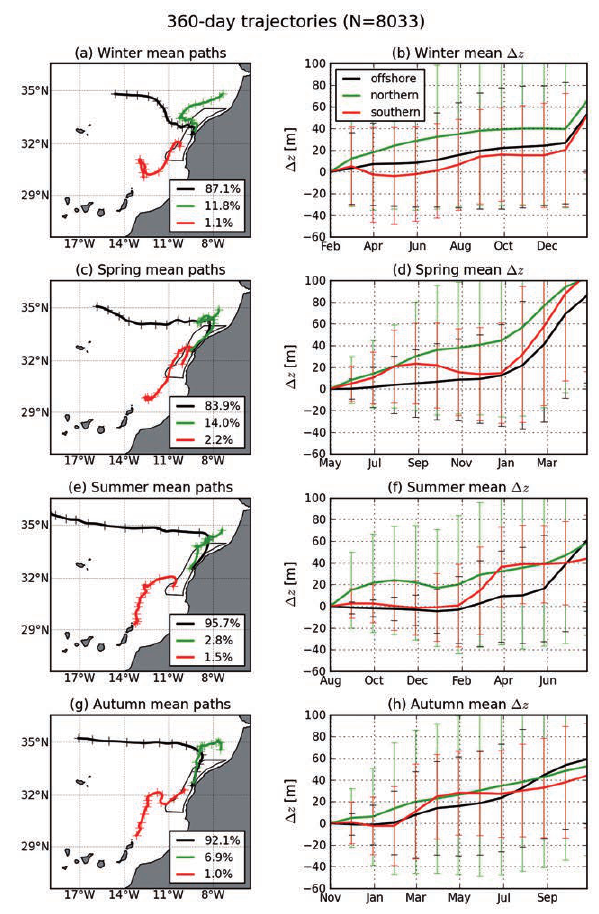
f ig . 7. – Seasonal mean (left panel) ∆ z and standard deviation; and corresponding mean paths (right panel) for 0 - 40 m filtered trajec- tories representing offshore, northern, and southern pathways from backwards runs 5-8 (Table 1). The percentage contributions of the total sample ( N ) to each pathway are given in the right panel legends, where it can be seen that the southern pathway is not significant in any season and can be neglected. The ∆ z data are subsampled at a monthly frequency; the corresponding points for each month in the mean trajectory paths are indicated by